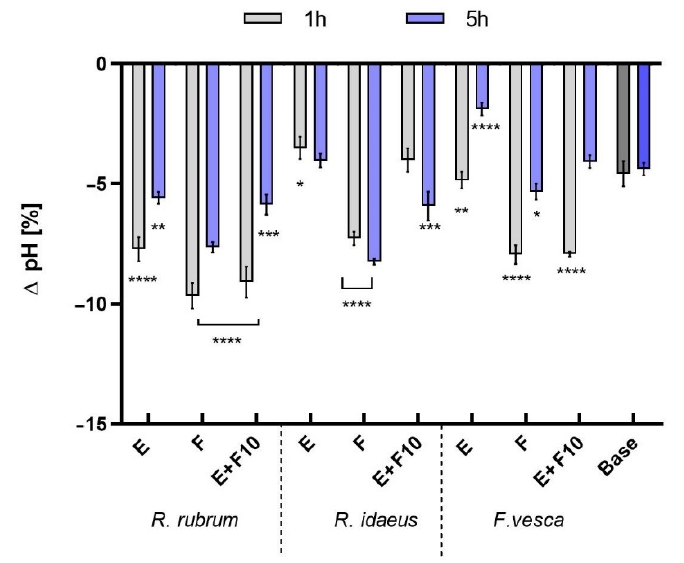
Figure 9. The influence of model skin tonics with R. rubrum, R. idaeus, and F. vesca extracts (E), ferments (F10), and extracts + ferments (E + F10) on skin pH. Data are the mean ± SD of three independent measurements. **** p < 0.0001, *** p < 0.001, ** p < 0.01 and * p < 0.05 compared to the base tonic.